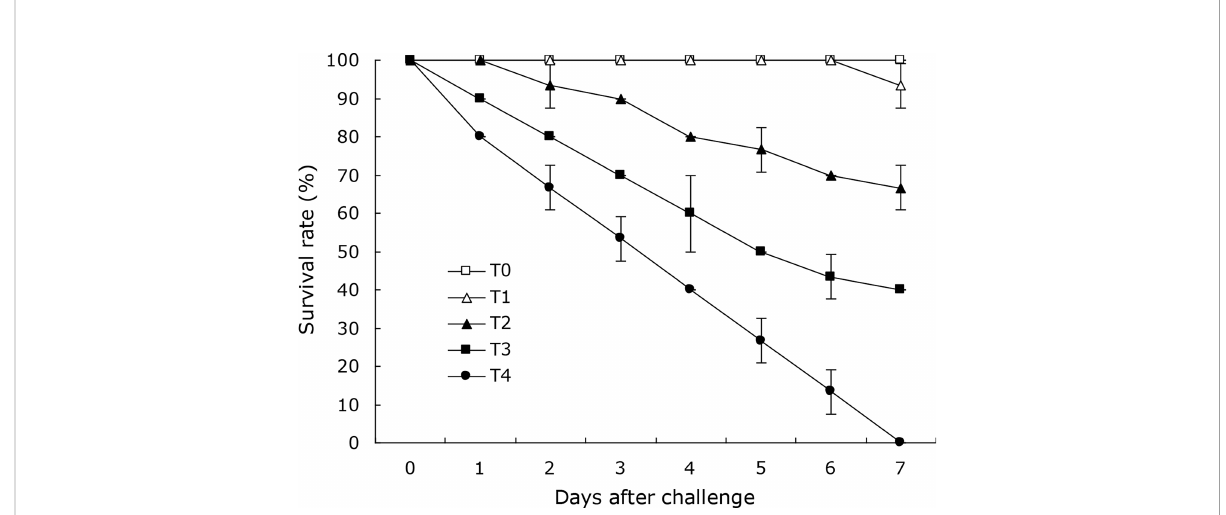
FIGURE 4 Survival rates of experimental coral trout infected by the DX2 isolate. T0, 0 CFU mL -1 ; T1, 2.1 × 10 4 CFU mL -1 ; T2, 2.1 × 10 5 CFU mL -1; T3, 2.1 × 10 6 CFU mL -1; T4, 2.1 × 10 7 CFU mL -1 . Data are presented as mean ± standard